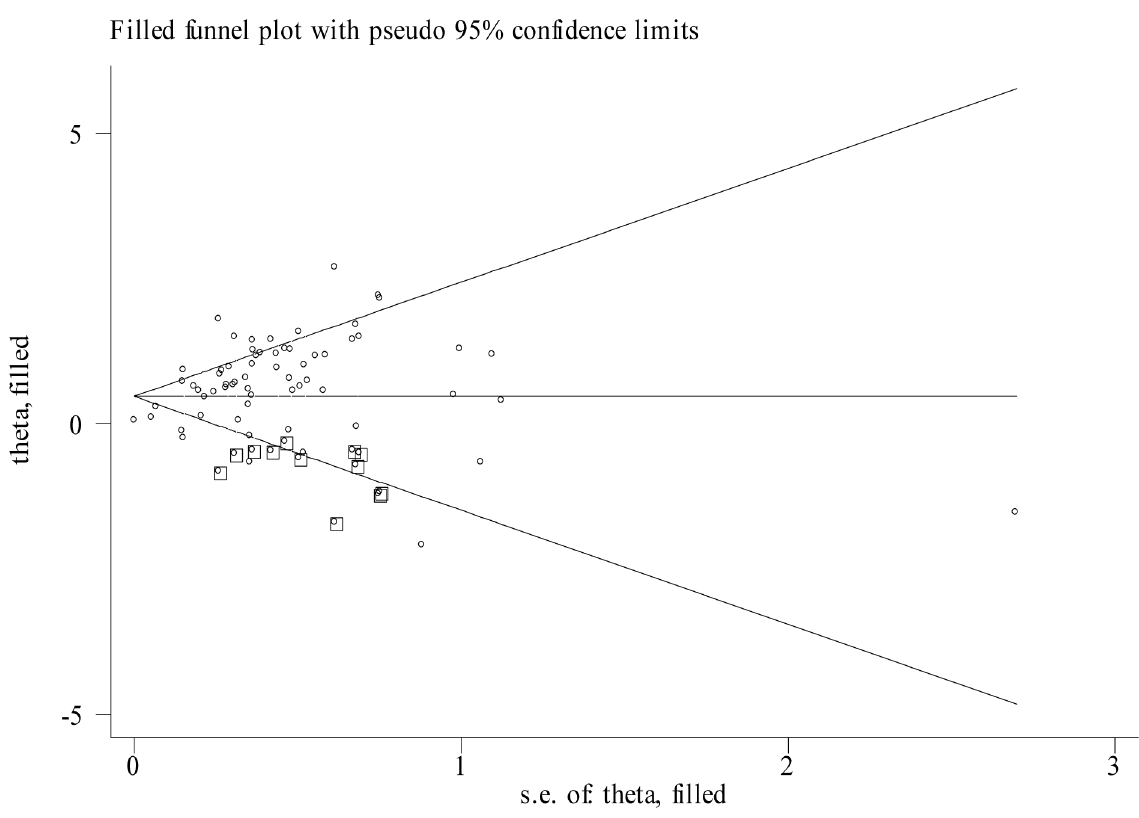
Figure 3. Funnel plot adjusted with trim and fill method for overall survival. Circles: included studies. Diamonds: presumed missing studies.